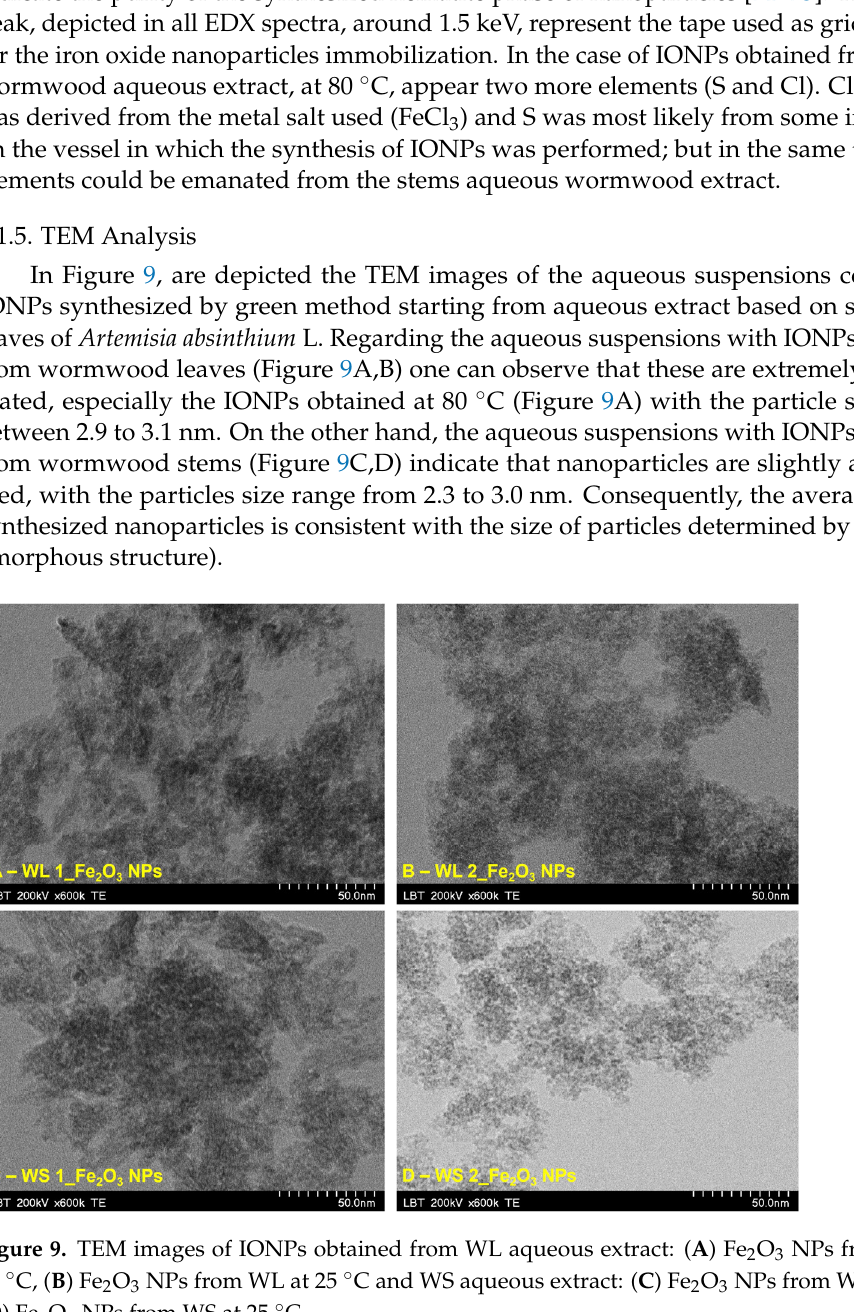
Table 1. The size distribution particles as a function of counts.